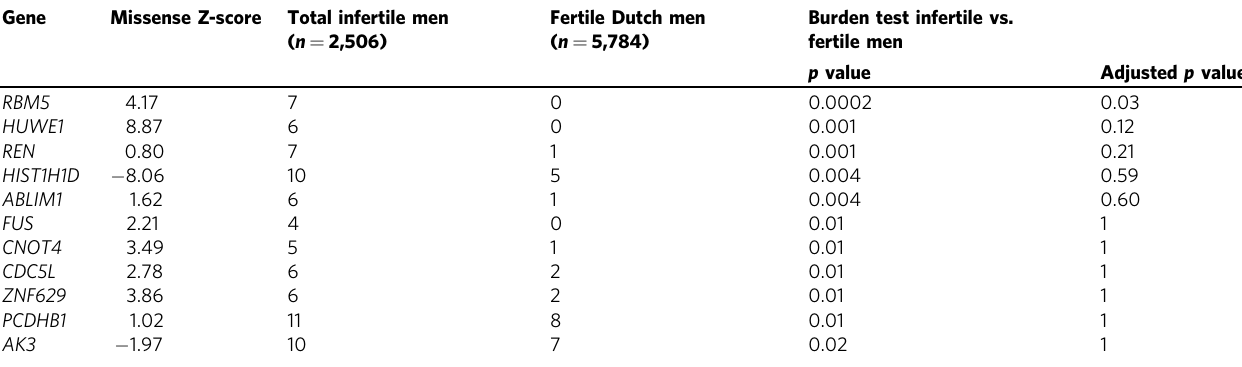
Table 2 Rare pathogenic missense mutations in exome data from various cohorts of infertile men and fertile control cohorts. Gene Missense